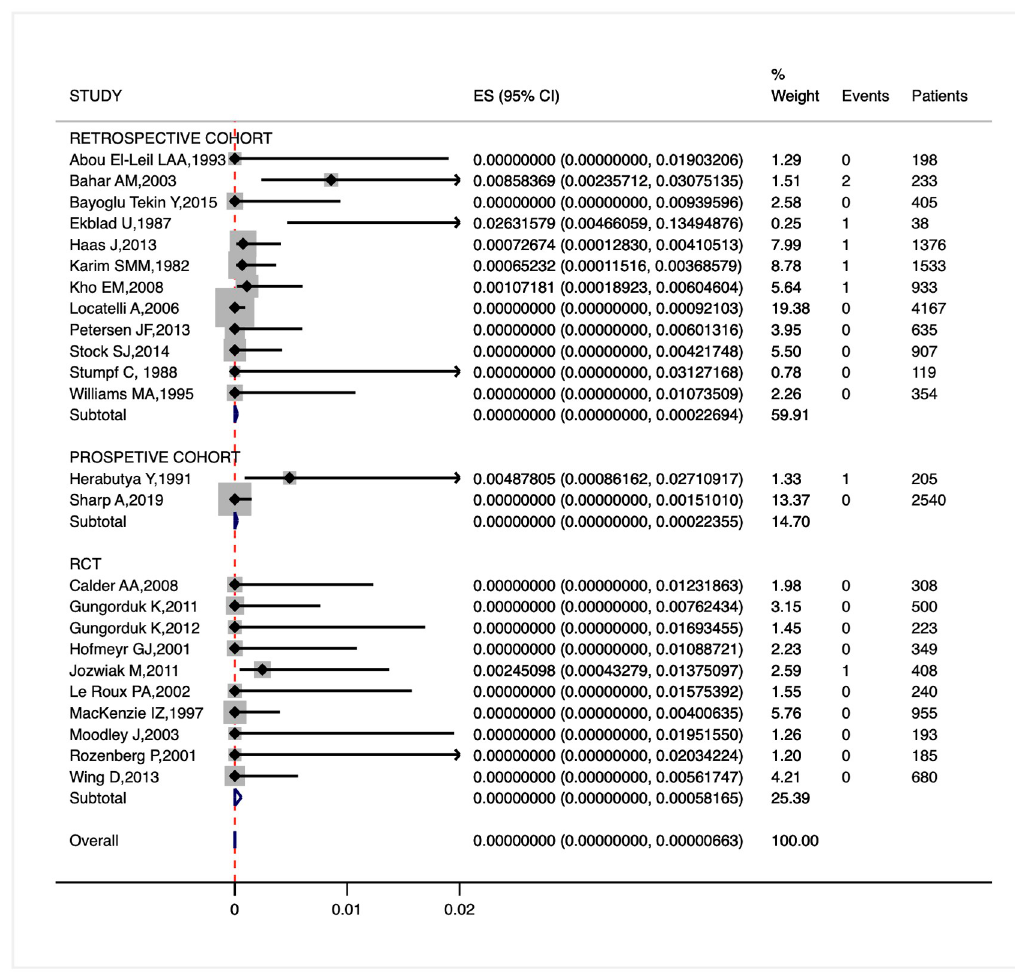
Fig 3. Forest plot for the prevalence of uterine rupture among women with unscarred uterus treated with PGE2.